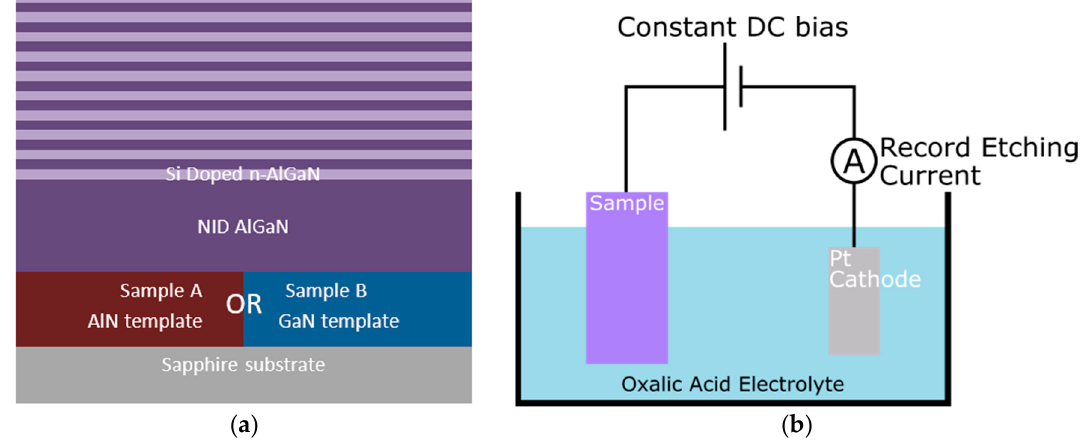
Figure 1. ( a ) Schematic diagram of the AlGaN samples grown on two separate templates, sample A on AlN and sample B on GaN. The distributed Bragg reflectors (DBRs) are made of ten pairs of ca. 50 nm of Si doped (1 × 10 19 cm − 3 ) n-AlGaN and ca. 35 nm of non-intentionally doped (NID) AlGaN. ( b ) Experimental setup of the electrochemical etching (ECE), as described in [6].